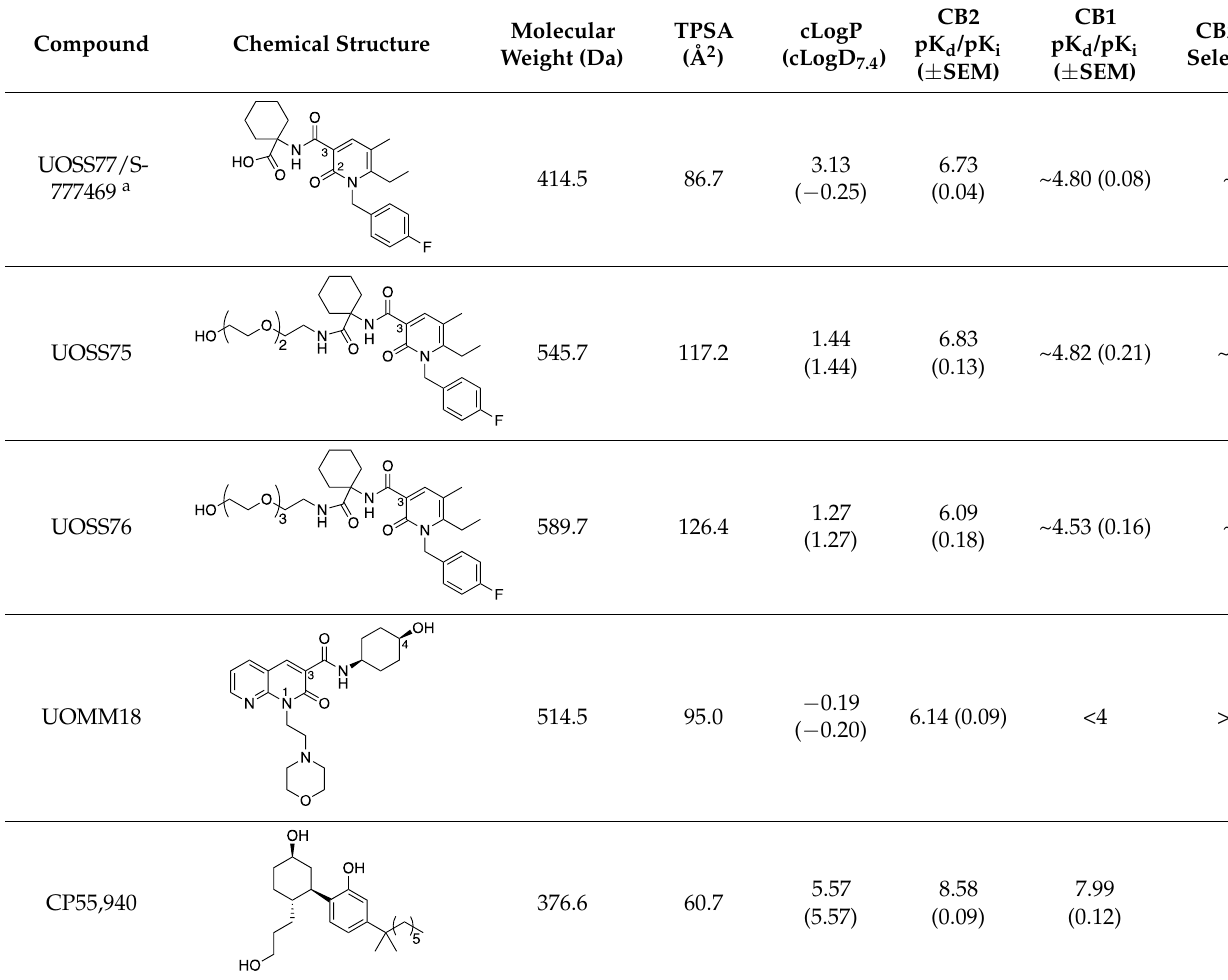
Table 1. Physiochemical properties, human CB2 and CB1 binding affinities, and CB2 selectivity (relative to CB1) for studied compounds. Affinity is provided as pK d for CP 55,940, or pK i for all other compounds. Some parameters are approximate (~, <, >) due to there being incomplete displacement of the radioligand at the maximum compound concentration tested. a first reported in [6].